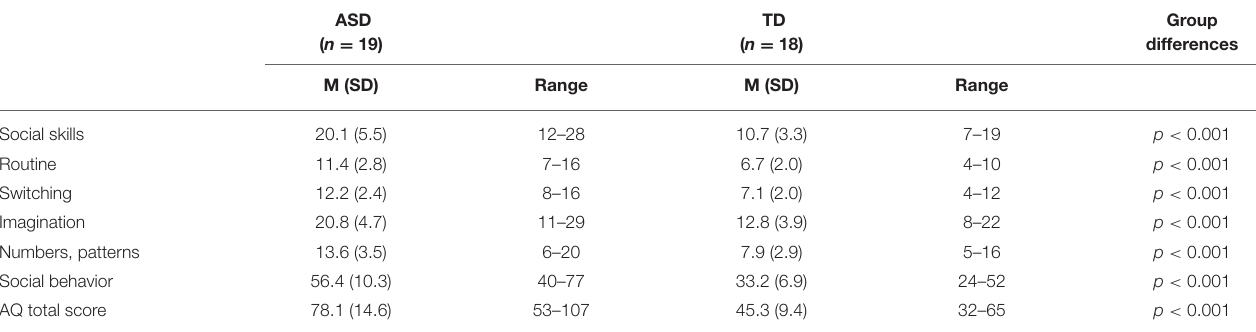
TABLE 2 | AQ-28 scores of the ASD and TD group and differences.